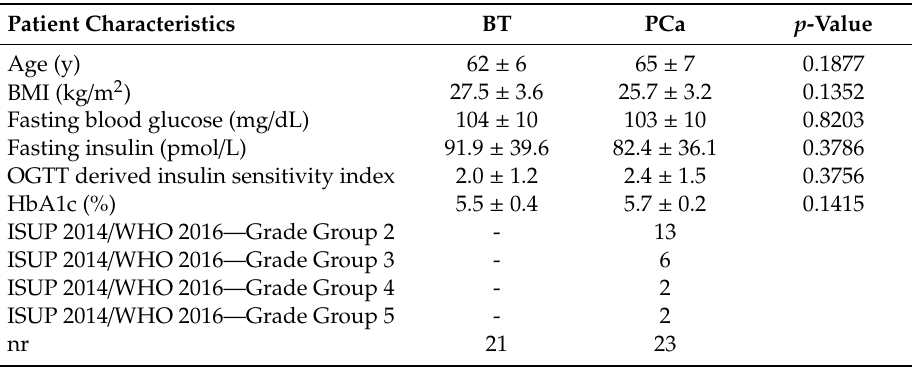
Figure 4. Main biochemical pathways with significant differences between prostate cancer (PCa) and adjacent benign tissues (ABT). ↓ and the blue colors depict metabolites with significantly lower content, while ↑ and the orange colors depict those with significantly higher content, in comparison of PCa to ABT. Arrowheads denote glycolytic enzyme steps. Table 2. Patient characteristics—extended cohort.